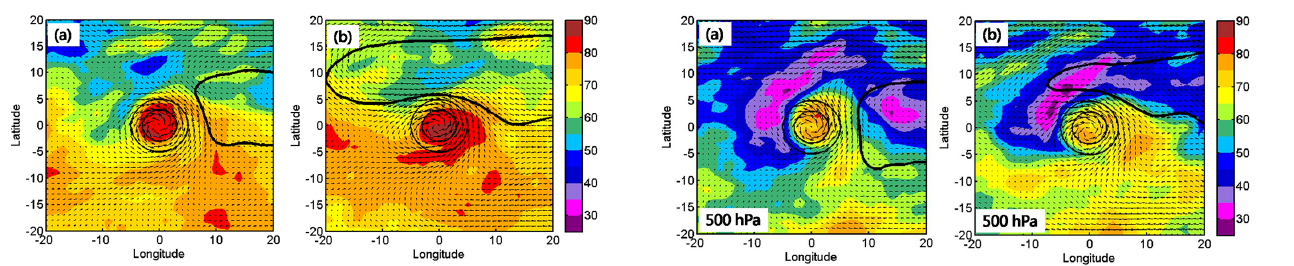
Figure 7. As in Fig. 4 but at time t + 48h .